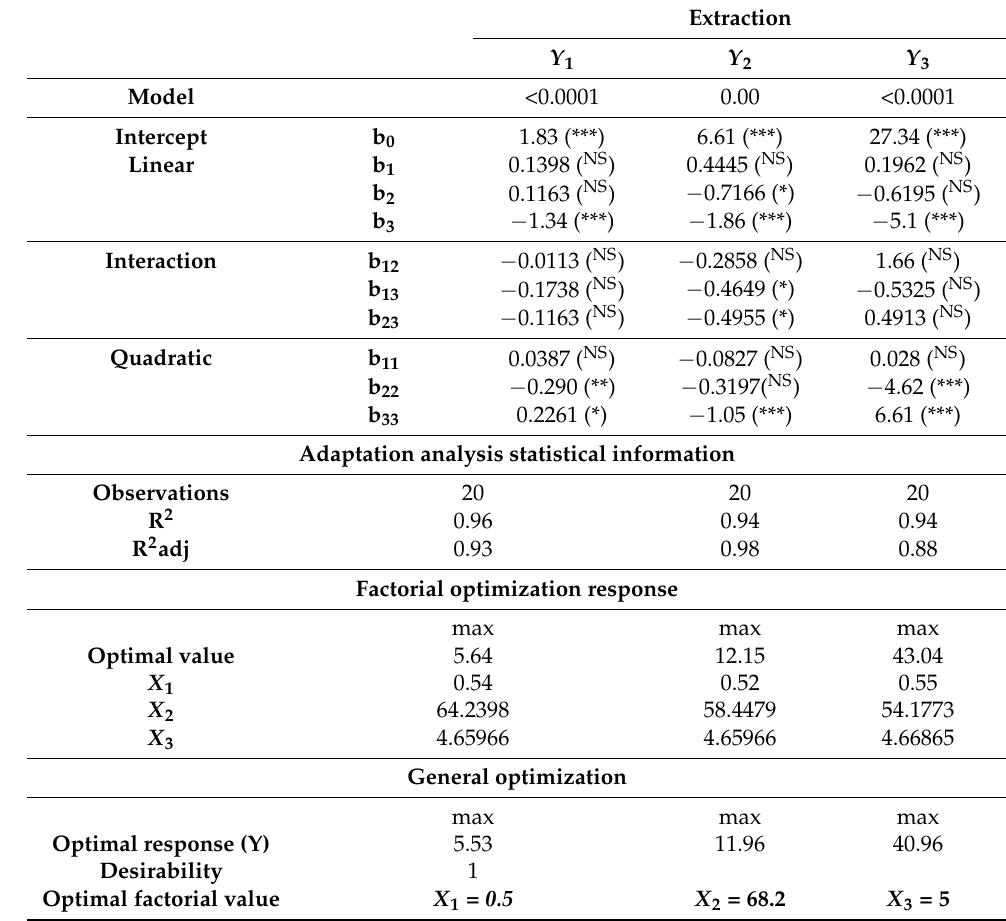
Table 9. Statistical analysis (ANOVA) of the central composite design (CCD), including response terms for building the predictive models and optimal response values for the parametric response